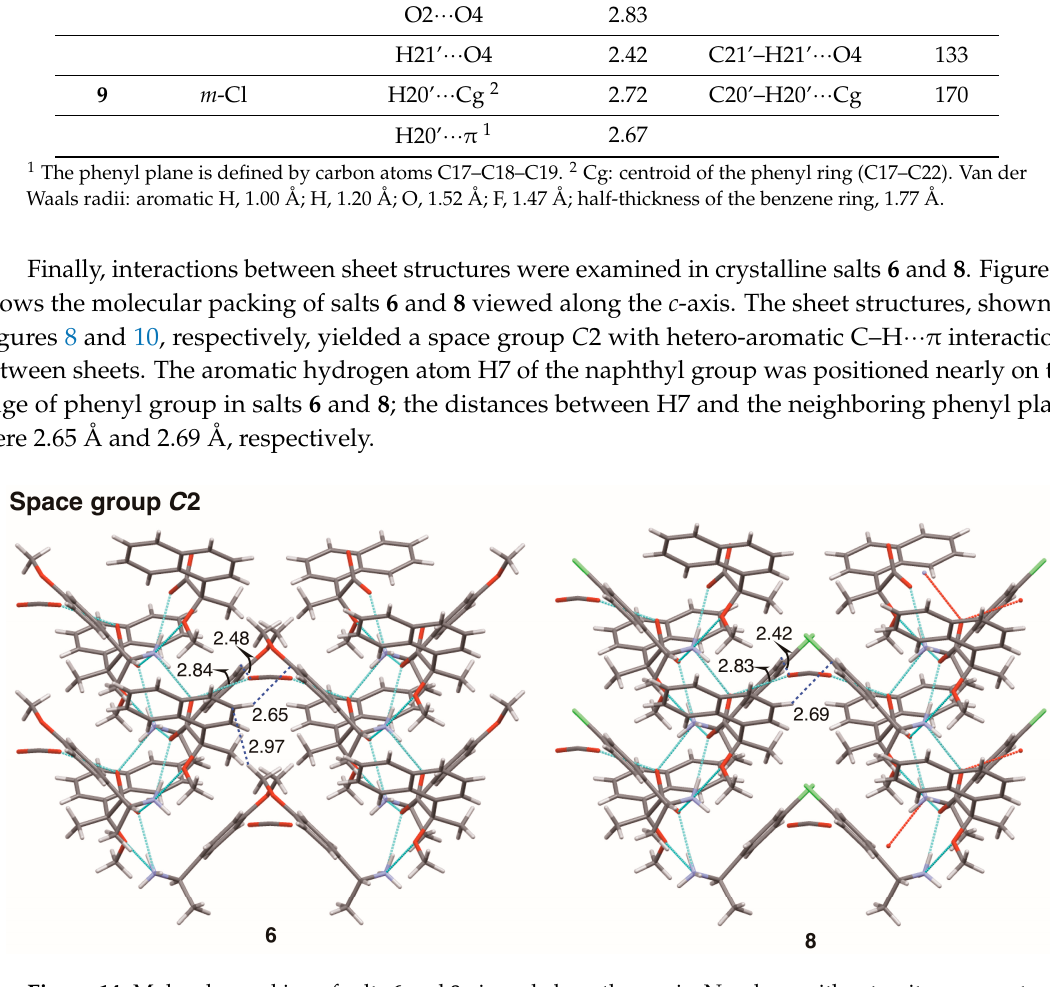
Table 6. Interatomic distances and angles between the sheet structures of salts 6–9 .